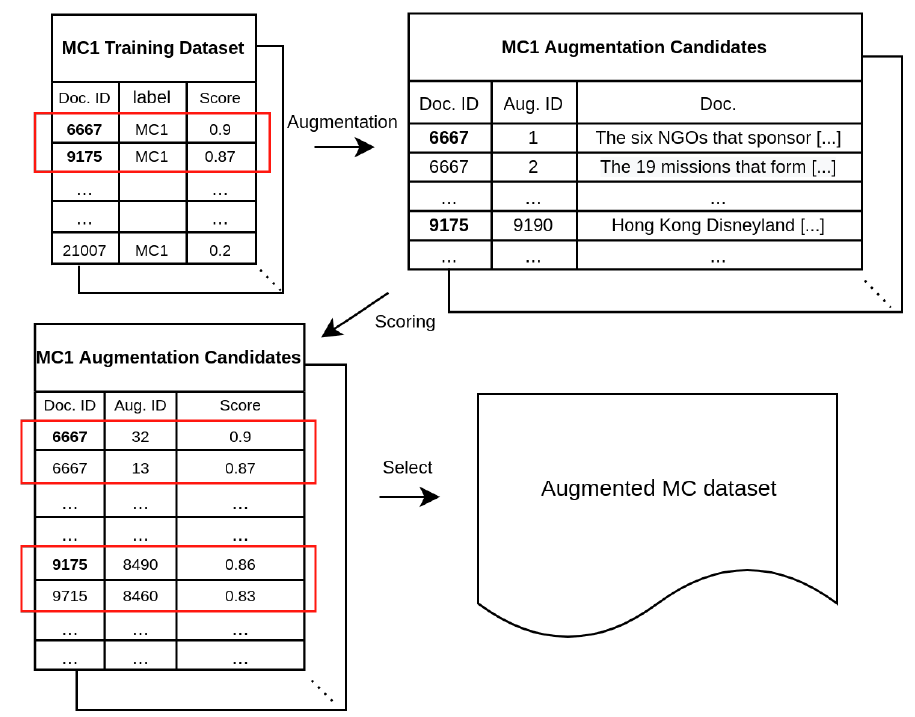
Figure 2. Workflow for the selective augmentation of